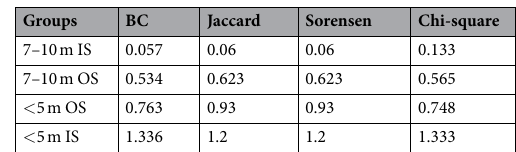
Table 3. Results of the MVDISP routine. IS, Inner-shelf; OS,